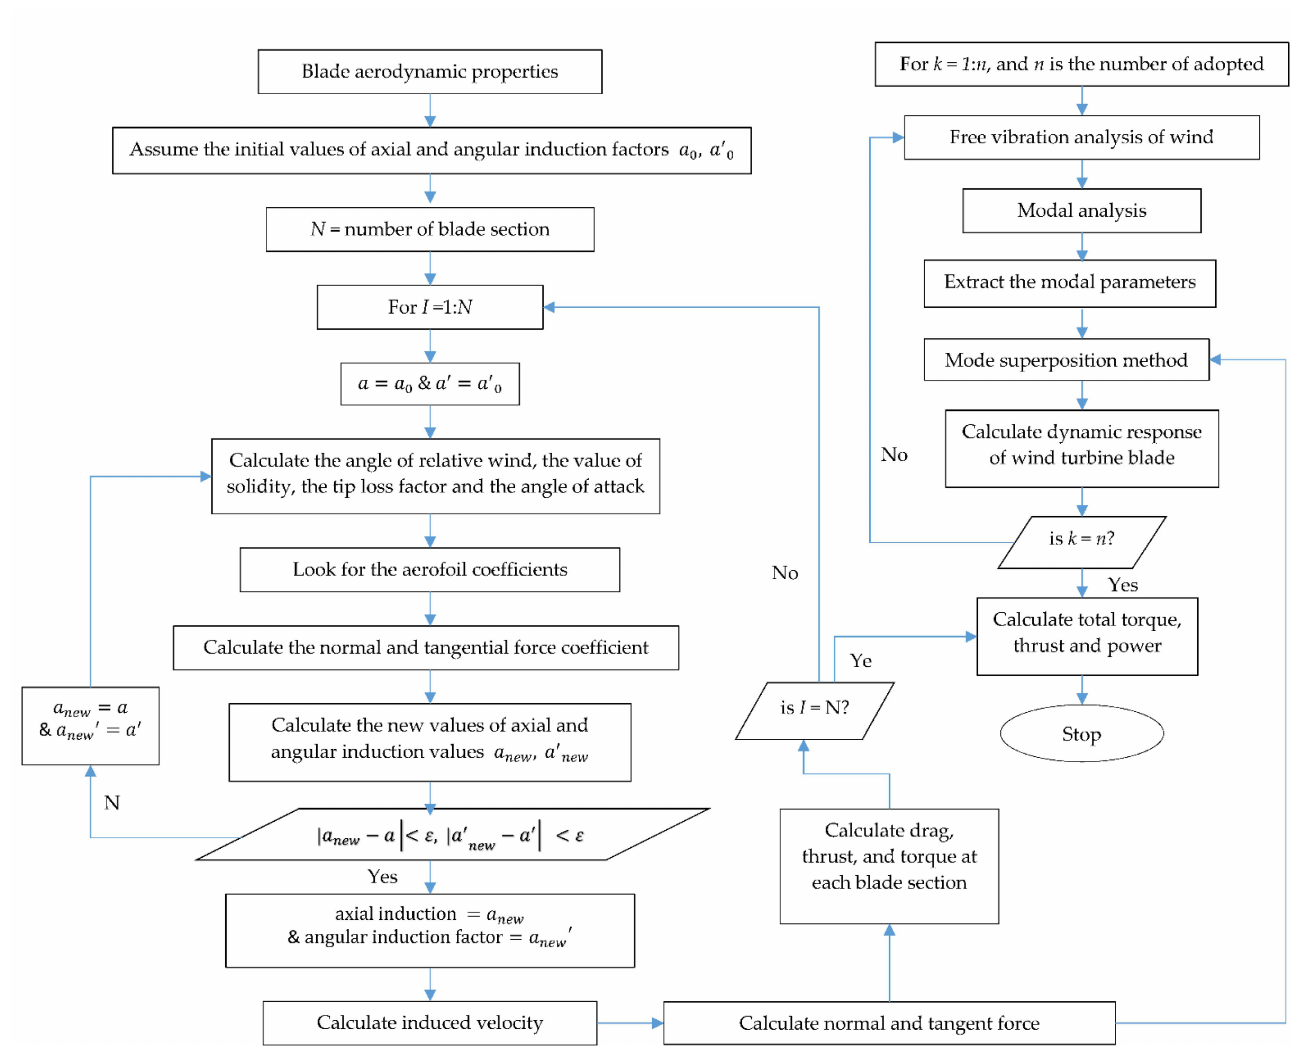
Figure 8. Forced vibration computational